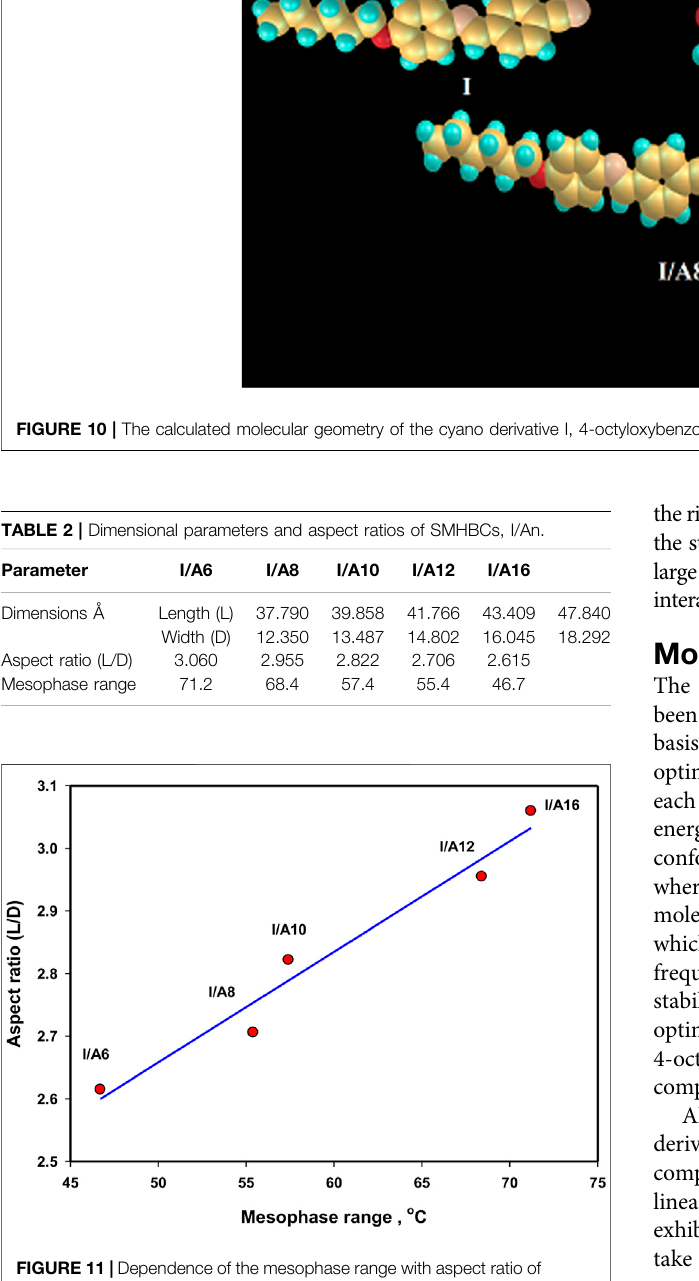
Frontiers in Chemistry |